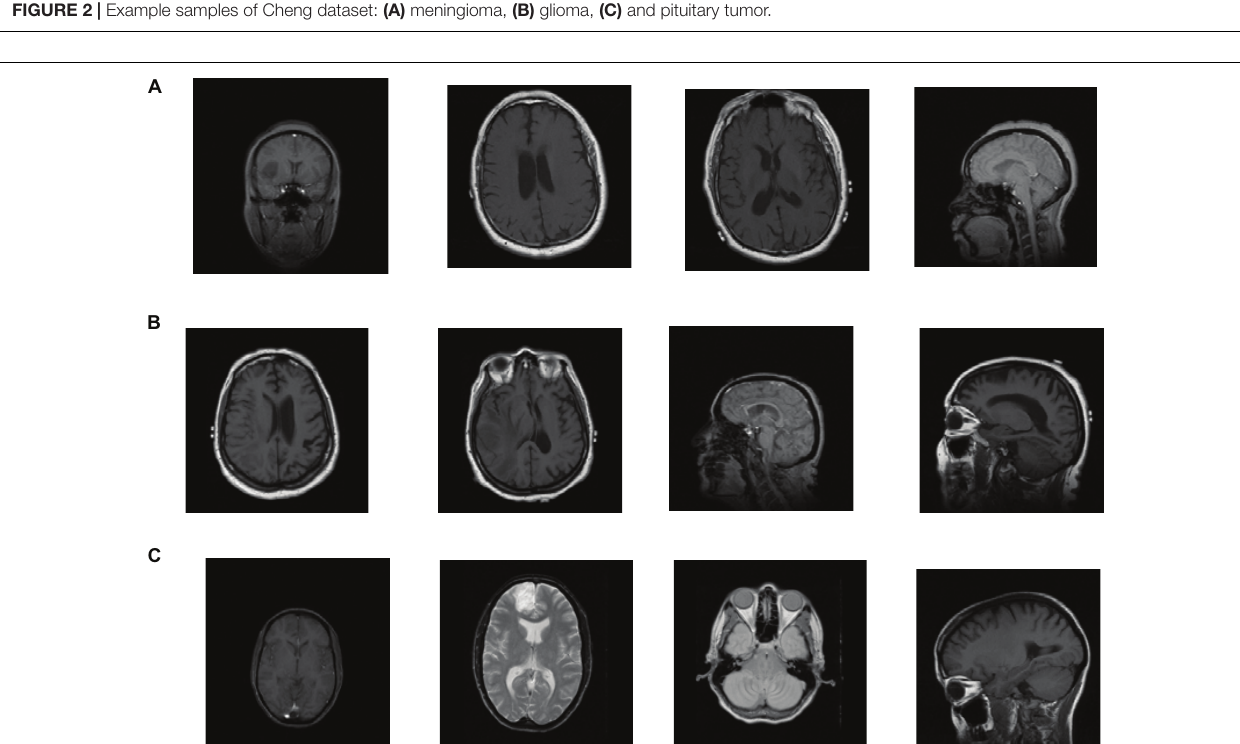
FIGURE 3 | Example samples of REMBRANDT dataset: (A) AST, (B) GBM, and (C) OLI.